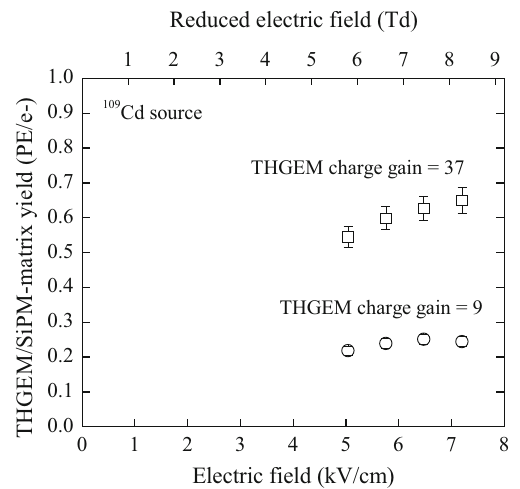
Fig. 15 THGEM/SiPM-matrix readout: THGEM/SiPM-matrix yield as a function of the electric field or reduced electric field in the EL gap at the average energy of 82 keV, deposited by gamma-rays from 109 Cd source in liquid argon, measured at two THGEM charge